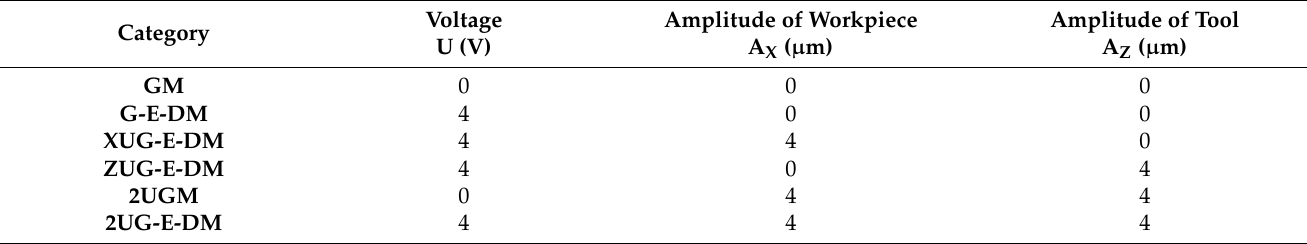
Table 2. The comparative test parameters of different processes.